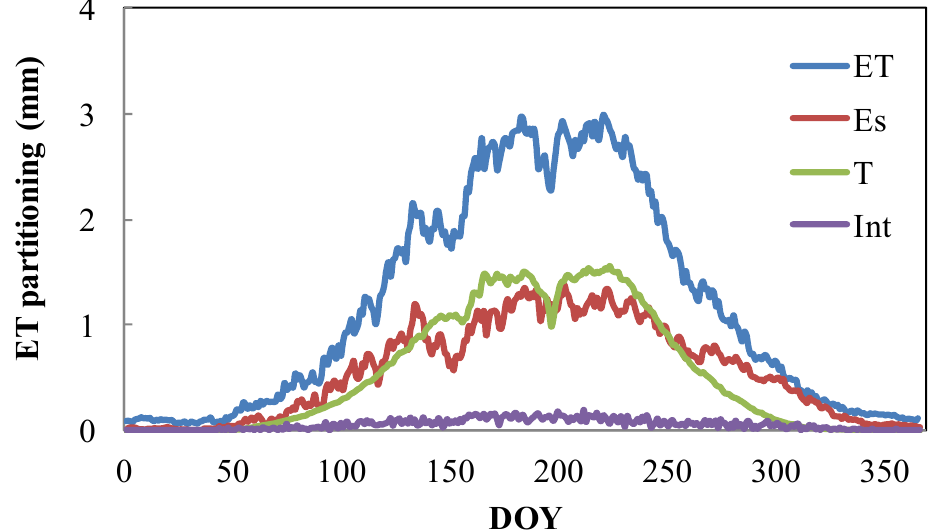
Figure 4. Evapotranspiration and its components estimated by the SOILWAT2 model in rainfed maize farmland during the year.